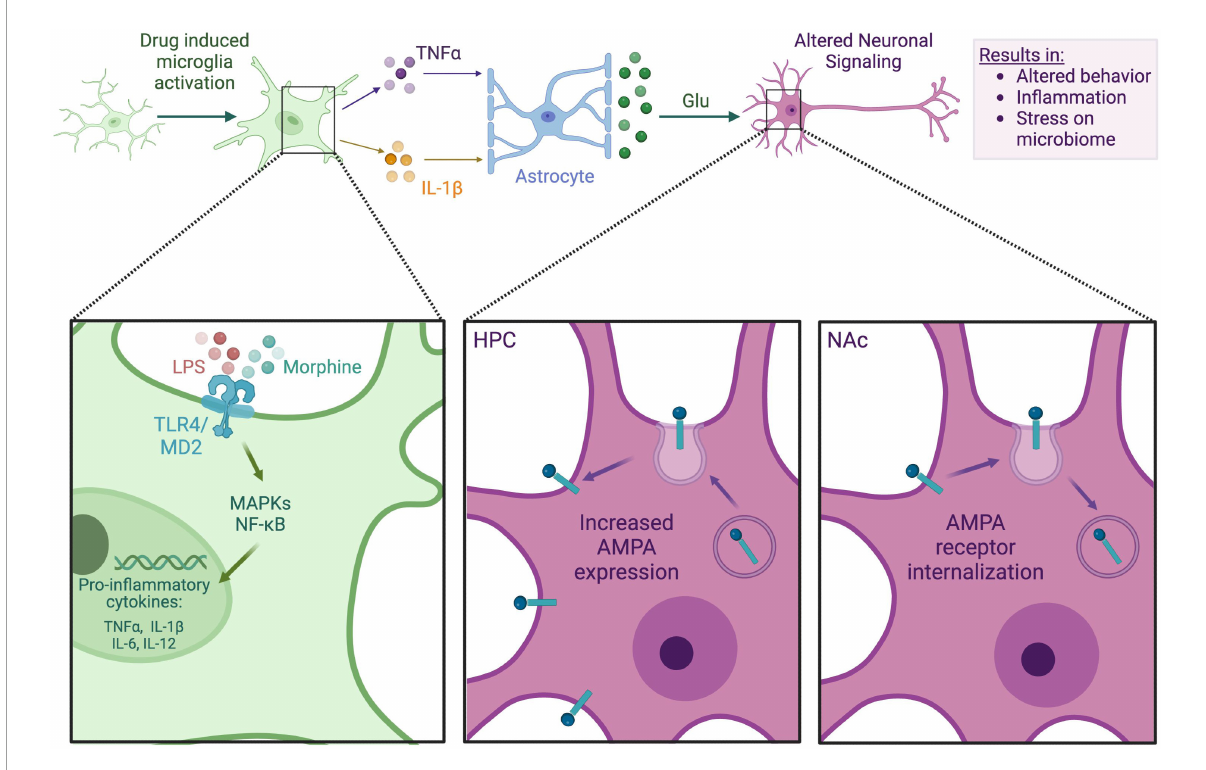
FIGURE1 Microglia-neuron interaction in an opioid context. This figure depicts the general mechanism by which morphine may impact neuronal signaling via the microglia. Either LPS from a dysbiotic microbiome or morphine itself binds to microglial TLR4, prompting the release of proinflammatory cytokines such as TNF α and IL-1 β . These cytokines bind to local astrocytes, causing glutamate release. Glutamate binds to neuronal AMPA receptors, which are differentially expressed in the hippocampus (HPC) and NAc, causing altered neuronal signaling. Alterations in neuronal signaling can lead to addictive behaviors, neuroinflammation, systemic inflammation, and further stress on the gut